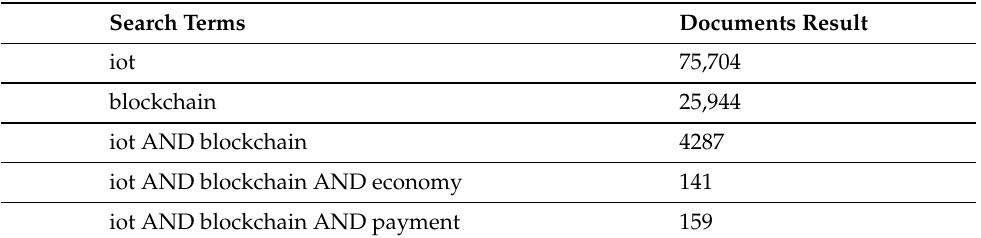
Table 4. Queries and corresponding retrieved documents for our identification